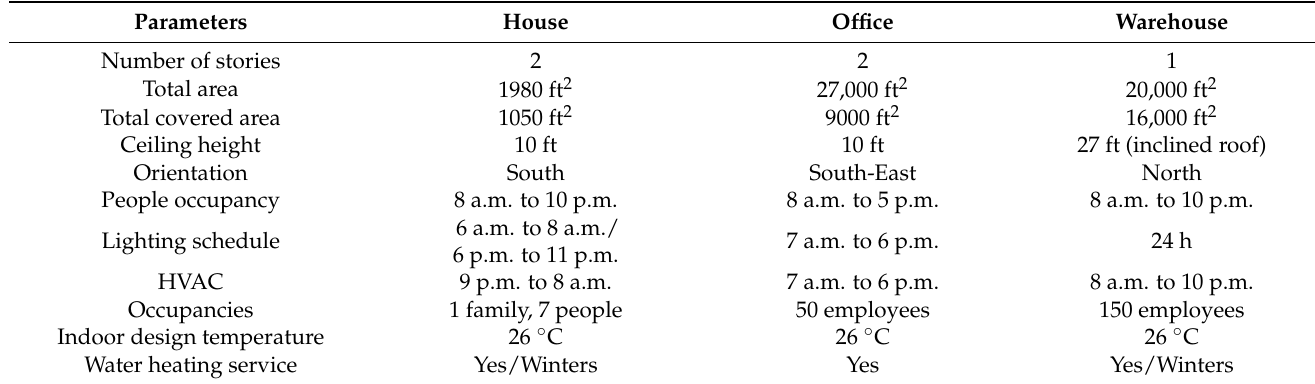
Figure 1. Model of the case study buildings: ( a ) House; ( b ) Office; ( c ) Warehouse. Table 2. Details of case study